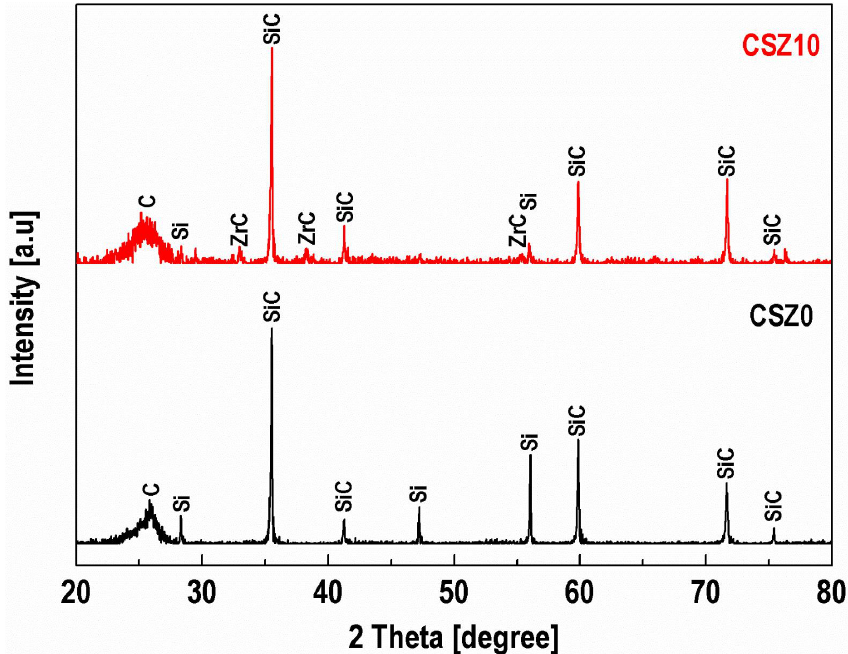
Materials 2020 , 13 , x FOR PEER REVIEW ff raction spectrum of CSZ0 and CSZ10. Figure 3. X-ray diffraction spectrum of CSZ0 and CSZ10. Figure 3. X-ray di